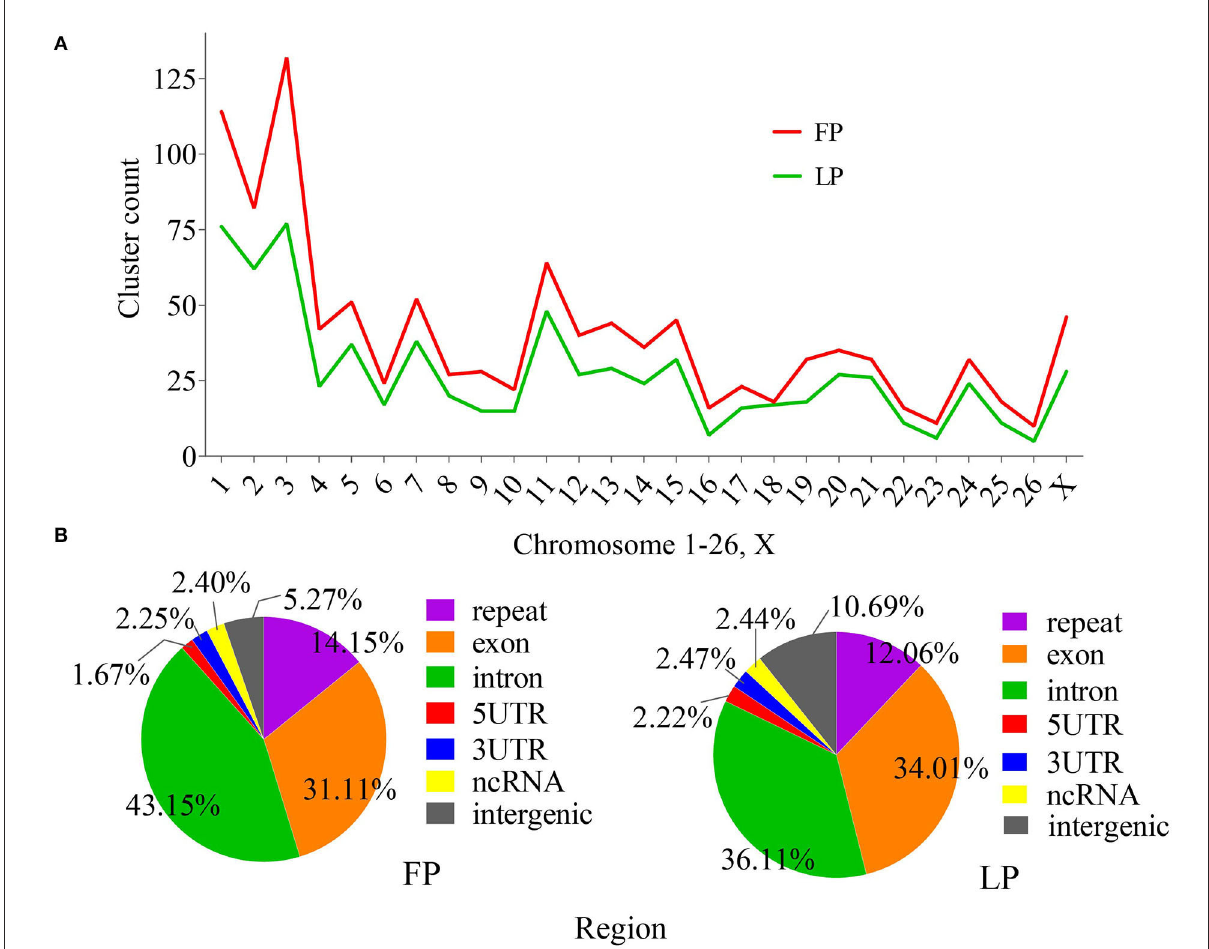
FIGURE3 Pi-clusters across various chromosomes (A) and genomic regions of matched piRNAs falling within the pi-clusters (B) in FP and LP groups.